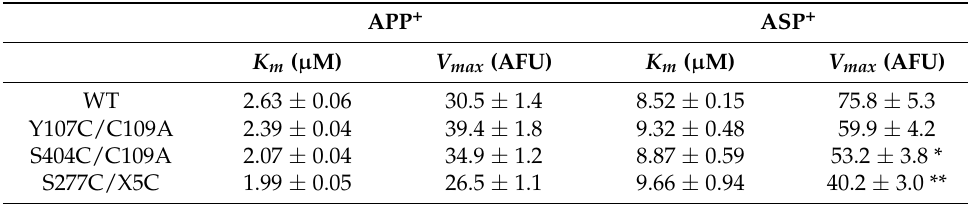
Table 1. Kinetic parameters of WT-SERT and cysteine mutants.